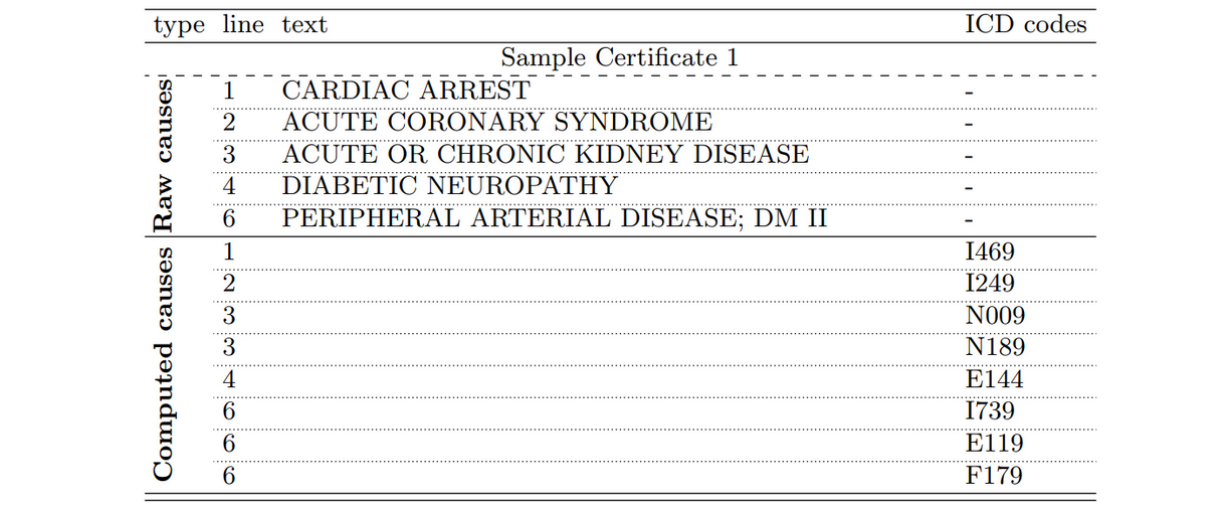
Figure 1. Example of causal chain of death as found on a French death certificate. Its corresponding underlying cause of death was defined as